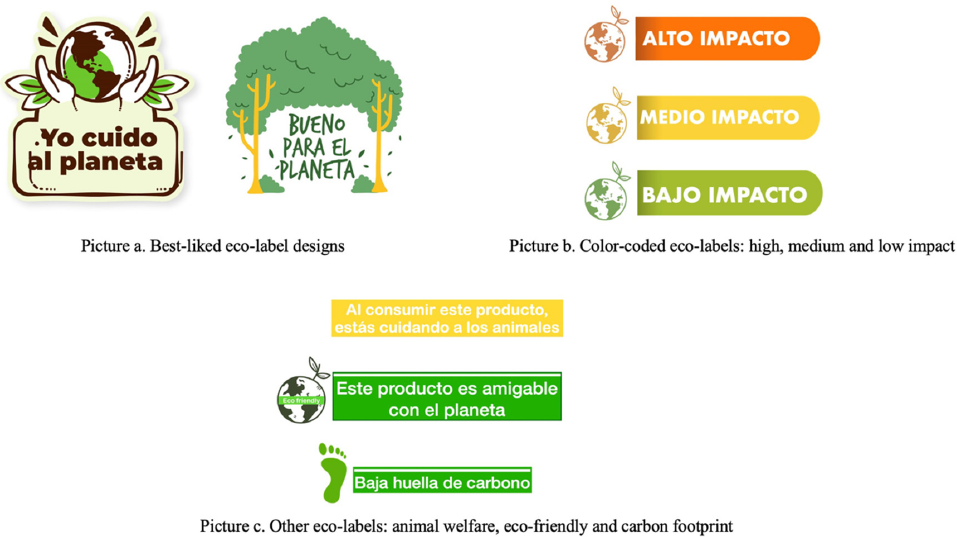
Figure 1. Sustainability labels designed by the investigators.